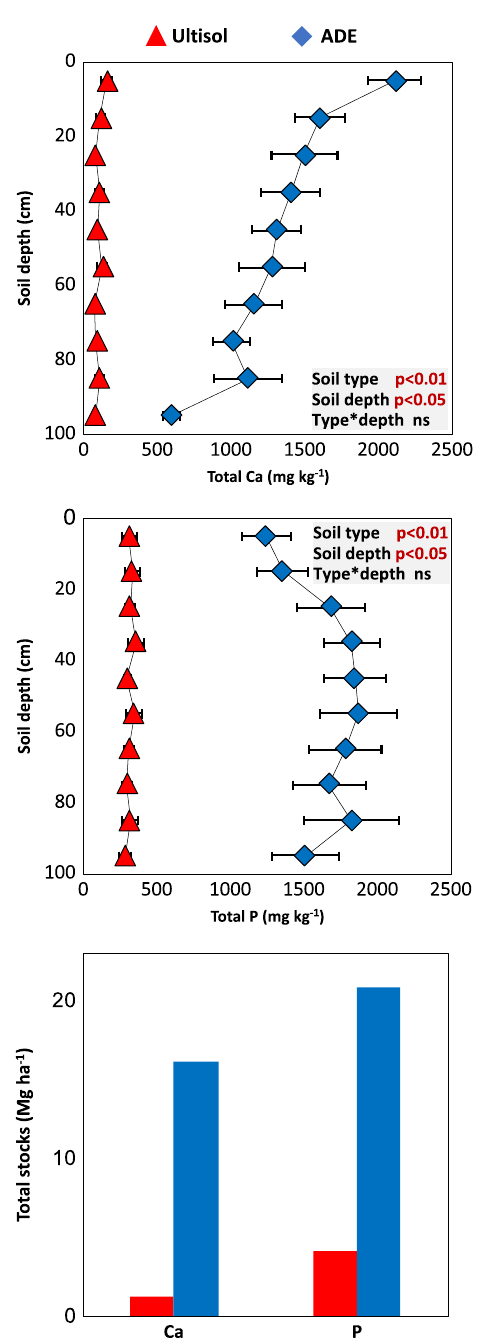
Fig. 3 Concentration of total phosphorus (P) and calcium (Ca) in ADE and Ultisol pro fi les. Data points show average values and error bars indicate two standard errors of the mean across maximum contrast pro fi les ( n = 5 for ADE and n = 5 for Ultisol for 10cm depth; Fig. 1). In all cases, a two-way analysis of variance shows signi fi cant differences between soil type and soil depth. The bar graph shows the total estimated stock of P and Ca up to 100cm depth calculated as the sum of average elemental concentration multiplied by bulk density at each incremental depth.